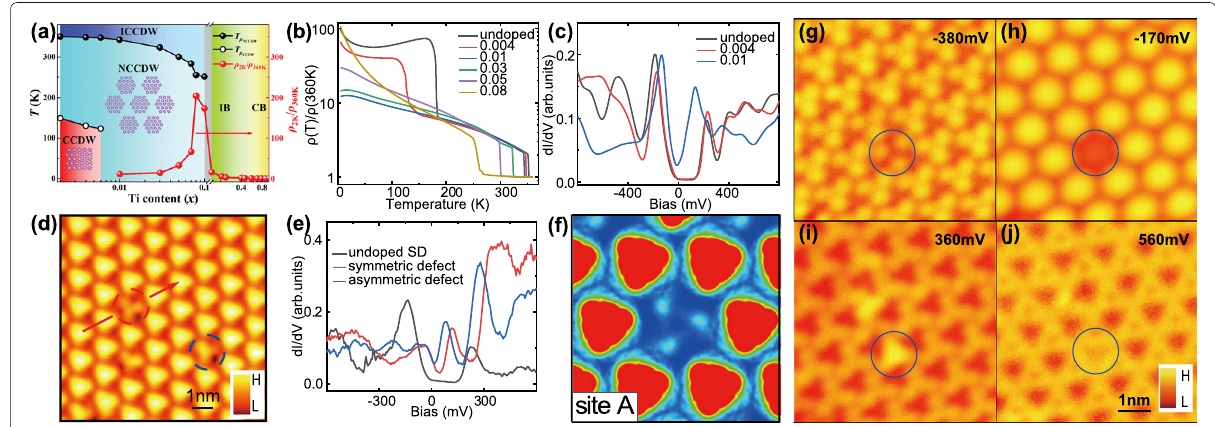
Fig. 8 Electronic properties and orbital texture of 1 T -Ti x Ta 1 − x S 2 . a Electronic phase diagram of 1 T -Ti x Ta 1 − x S 2 . b , c Temperature-dependent in-plane resistivity ratio ρ (T)/ ρ (360K) and typical dI / dV spectra for samples with different doping levels. d A 9 × 9 nm 2 topography for the x = 0.004 sample. Red andbluecirclesmarkasymmetricandanasymmetricTi-dopedSD,respectively. e dI / dV spectrameasuredatthecenterofanundopedSD,asymmetric, and an asymmetric Ti-doped SDs, respectively. f First-principles DFT calculation of symmetric Ti-doped SD. Red contours represent high charge densities. g - j Experimental dI / dV maps around a symmetric Ti-doped SD at different energies on the x = 0.004 sample. Taken from ref. [49, 50]